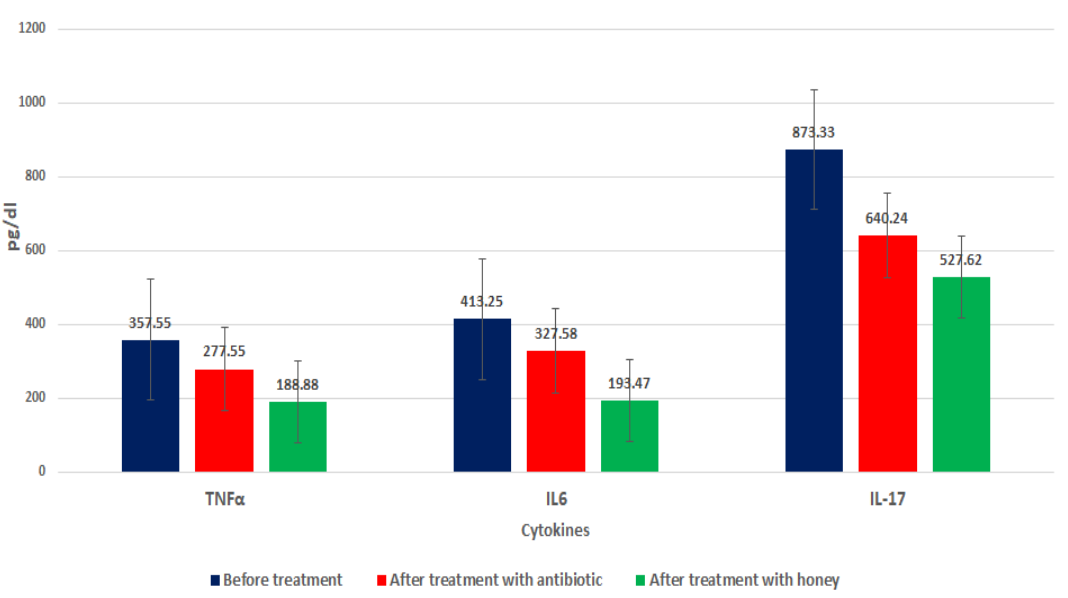
Figure 5. Cytokines measured before and after